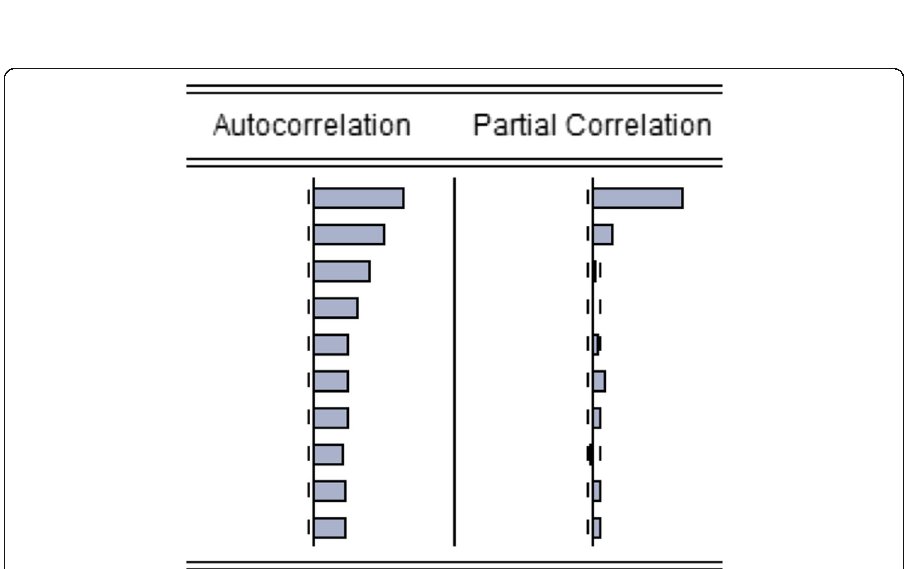
Fig. 1 Correlogram of exchange rate